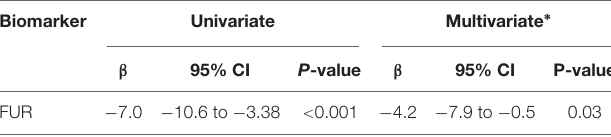
TABLE 4 | Relationship between changes in heart rate during head-up tilt test and selected biomarker in univariate and multivariate regression. Biomarker Univariate Multivariate